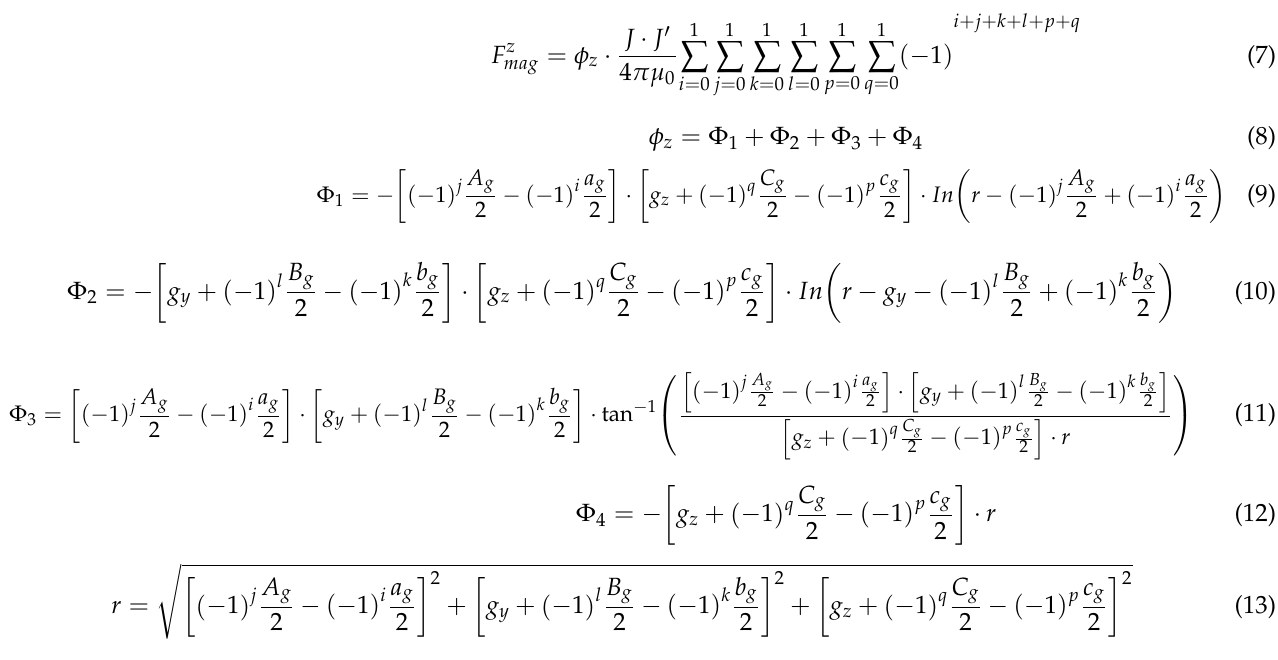
Figure 5. A hydroelectric energy harvesting application using the hybrid structure. When the disk rotates with the hybrid structure, the magnet on the disk generates a repulsive magnetic force on the cuboidal magnet on the beam. The beam then exhibits damped free damping vibration. According to the literatures [27,29], the magnetic force between the two magnets can be calculated